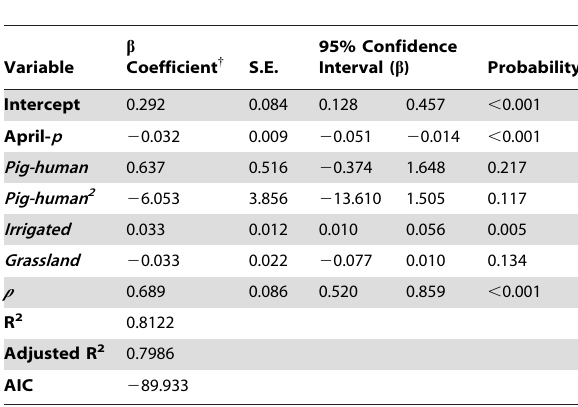
Figure S1 Map of Nepal district by development zone and region. Figure S2 Environmental variables used in full and parsimonious models. A) Mean May temperature, B) Mean of irrigated land and E) pig-to-human ratio.